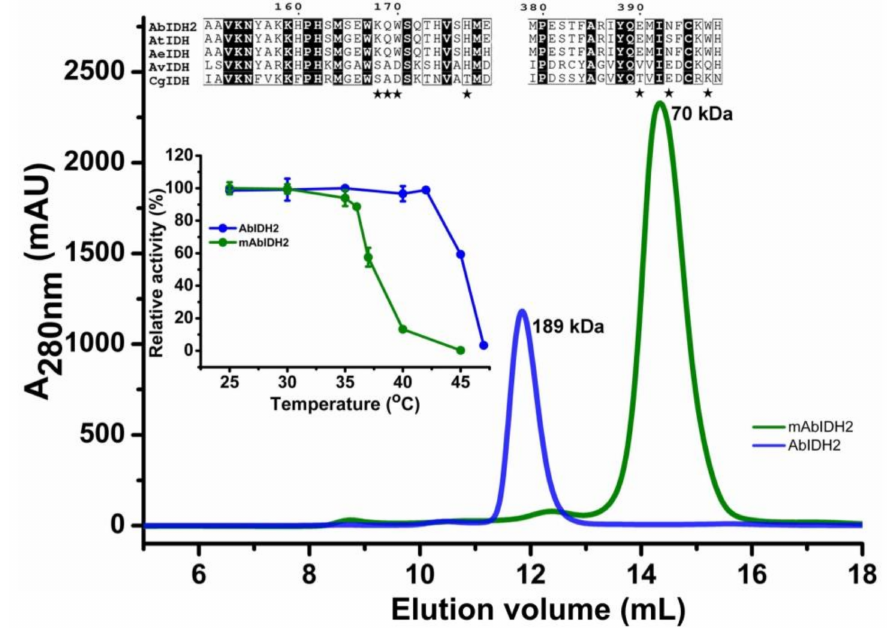
Figure 3. Characterization of the mutant mAbIDH2. The flow rate of the size exclusion chromatography was 0.5 mL · min − 1 and the proteins in the fractions were monitored at 280 nm. V e of the wild-type AbIDH2 and mutant mAbIDH2 were 11.78 and 14.35 mL, respectively. The upper insert panel shows the sequence alignment of the dimeric AbIDH2 with its homologous IDHs from Azoarcus tolulyticus (AtIDH, GenBank Accession WP_076602605.1) and Acidovorax ebreus (AeIDH, GenBank Accession WP_015913126.1) and two typical monomeric NADP-IDHs from Azotobacter vinelandii (AvIDH, GenBank Accession No. BAA11169.1) and Corynebacterium glutamicum (CgIDH, GenBank Accession No. WP_011013800.1). The residue numbering in the figure is based on the AbIDH2 sequence. The conserved residues are shaded in black. The residues that are involved in the dimer formation are marked by a pentagram (cid:70) . The lower insert panel shows the heat-inactivation profiles of the wild-type AbIDH2 and mutant mAbIDH2 from 25 to 47.5 ◦